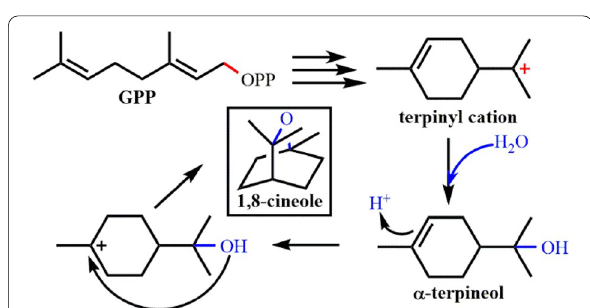
Fig. 8 Cyclization reaction catalyzed by cineole synthase. Terpinyl cation is quenched by water molecule, producing 1,8‑cineole through protonation induced cyclization